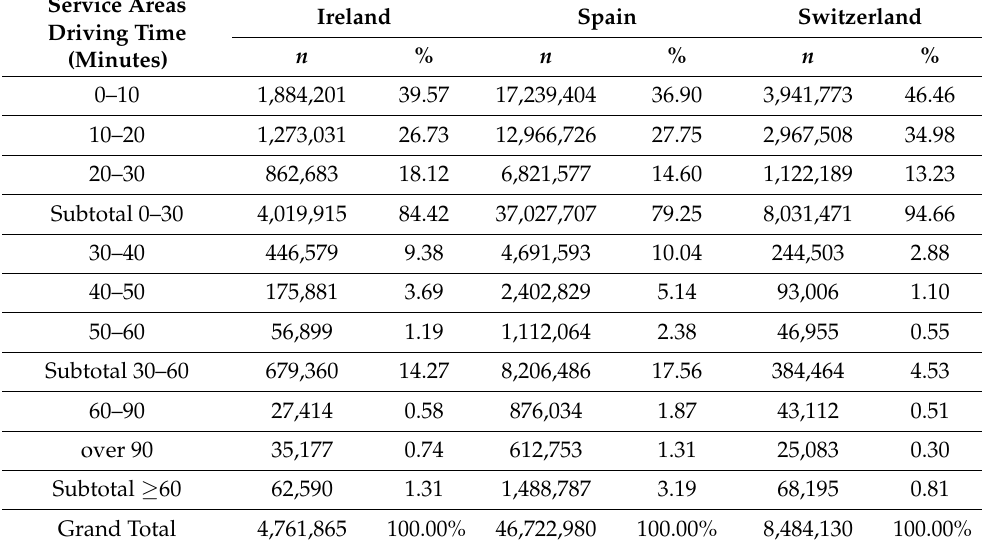
Table 1. Countries’ population living at service